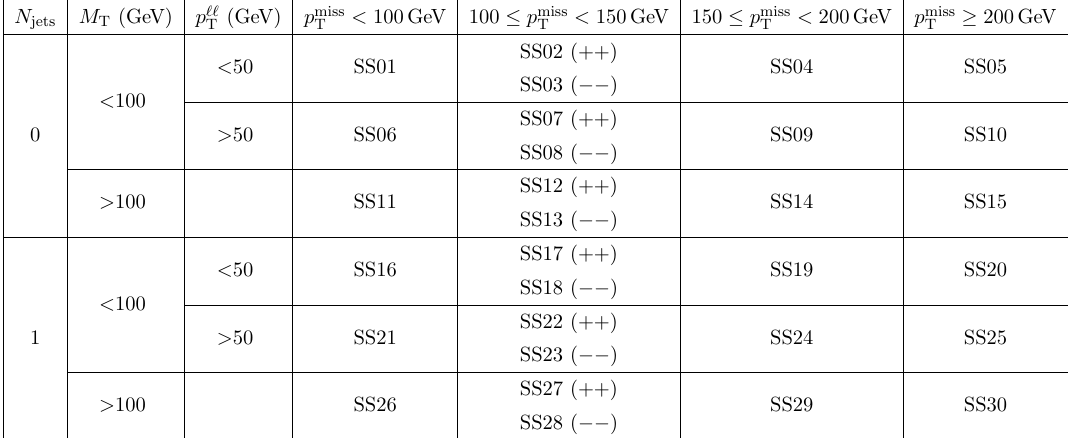
Table 1 . Search regions for events with two SS light-(cid:13)avor